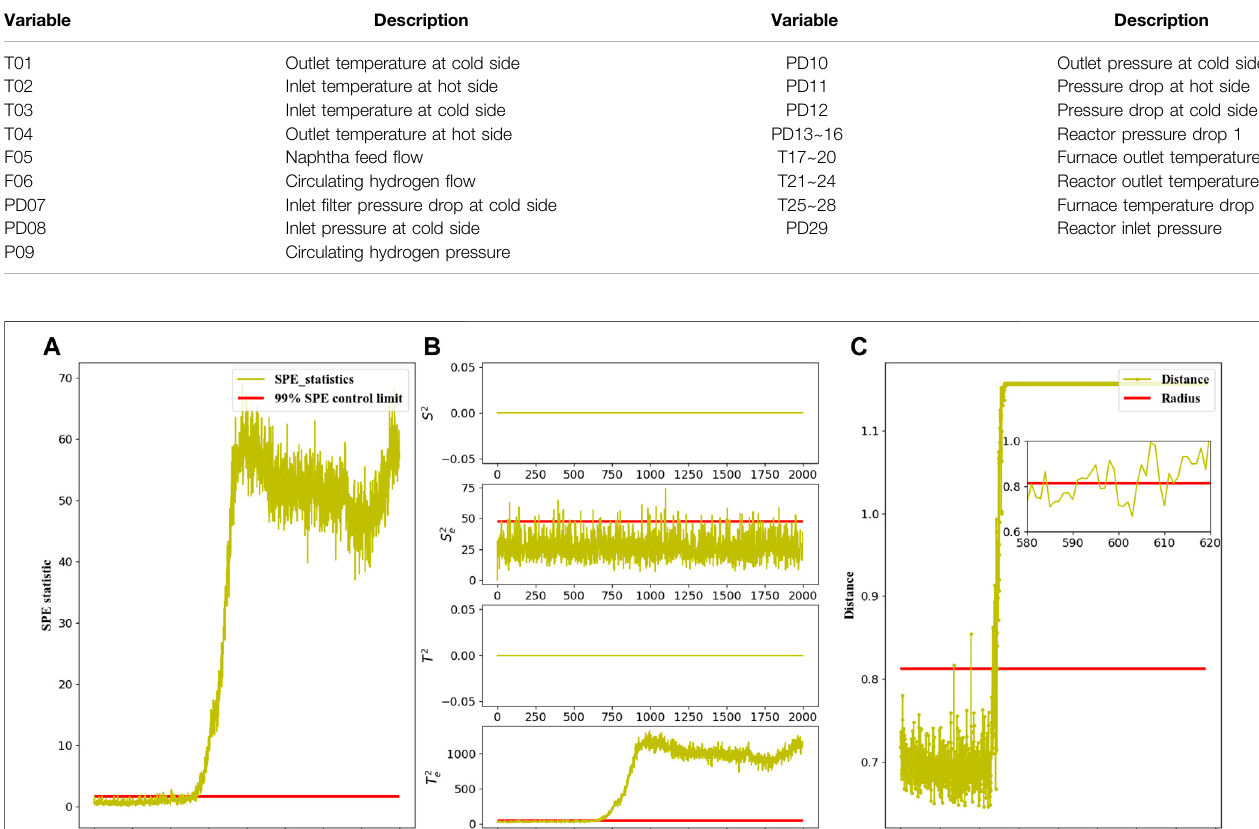
Frontiers in Chemical Engineering |